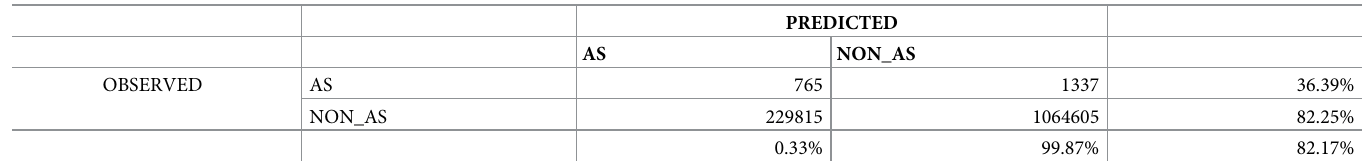
Table 2. Male all